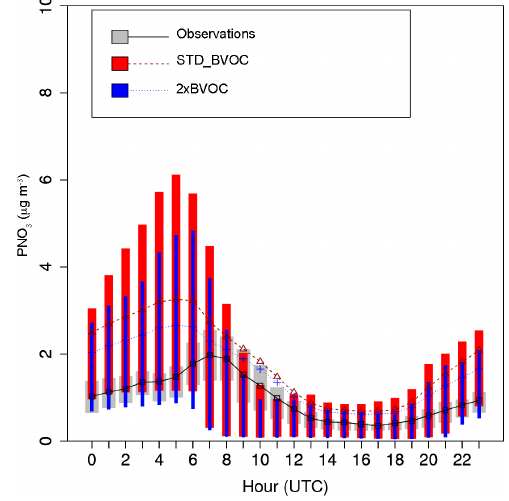
Figure 8. Hourly box plots showing the diurnal cycle of ob- served (grey) and modeled particulate nitrate concentrations with standard BVOC emissions (red) and with doubled BVOC emis- sions (blue) in June 2006 at Payerne. Bars show the 25th and 75th quantiles, while the mean is displayed by the